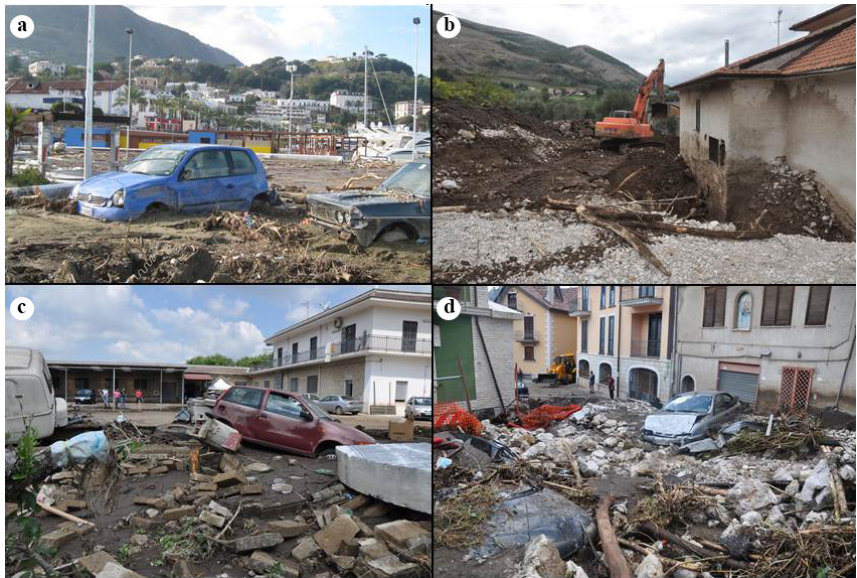
Figure 13. Typical examples of damage caused by alluvial events: (a) Casamicciola, 10 November 2009; (b) Buccino-Teglia, 7 October 2011; (c) Arienzo, 6 June 2014; (d) Solofra, 1 September